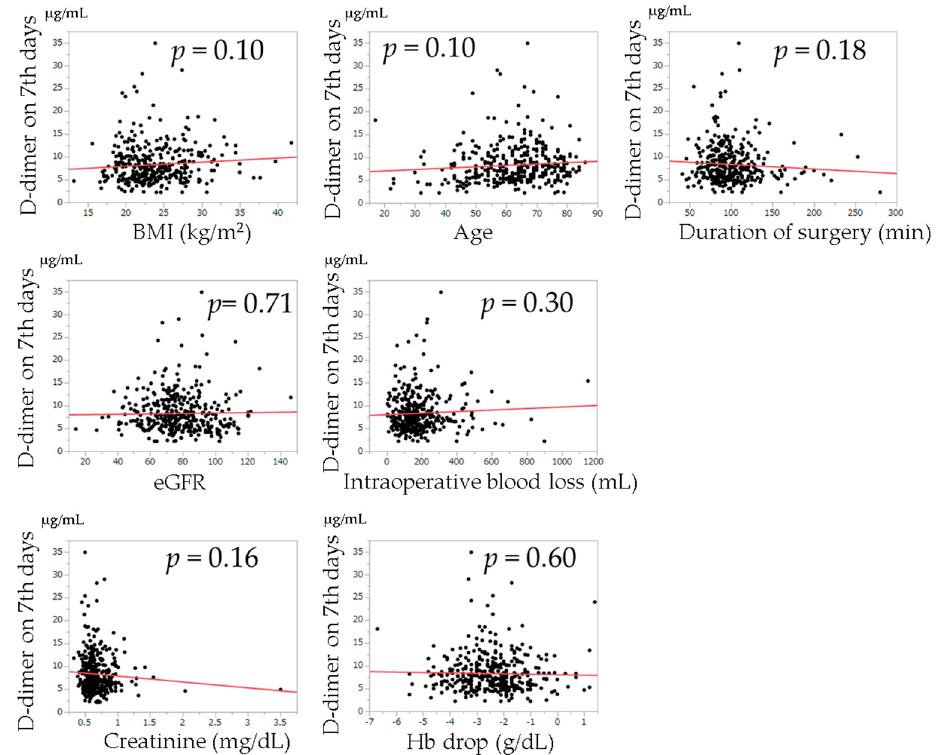
Figure 2. Univariate regression analysis of the relationships between each variable and D-dimer levels on the 7th postoperative day. The solid lines indicate regression lines. BMI: body mass index, eGFR: estimated glomerular filtration rate.